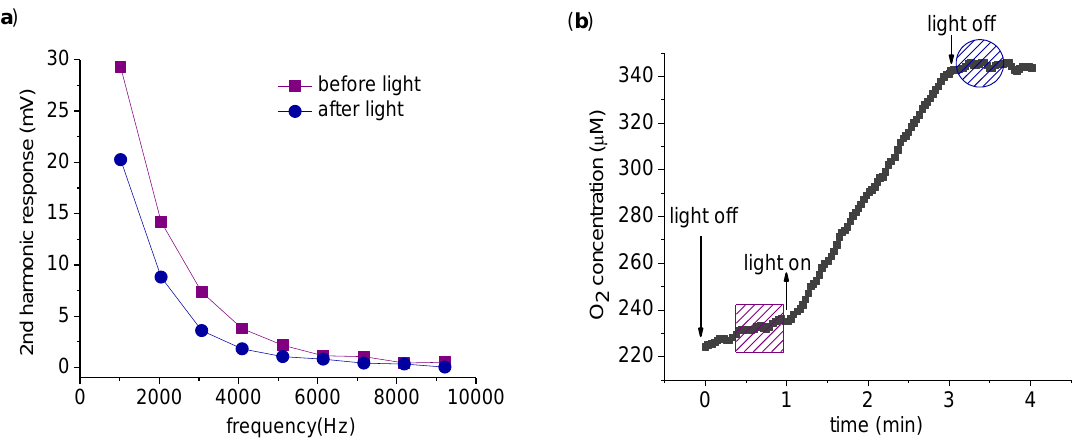
Figure 2. Measurement of the 2nd harmonic response with varying driving frequency. (a) 2nd harmonic response before (square) and immediately after (circle) a 2 min exposure to light. Both 2nd harmonic response measurements are taken in the dark, with each point the average of a 4 s acquisition and 8 V recorded at all times. The time span of harmonic measurement is indicated by a box (before light application) and a circle (after light application). The measurement was carried out with 0.2 mg/mL chlorophyll in 5 mL suspension buffer with 1.0 mM K described in the